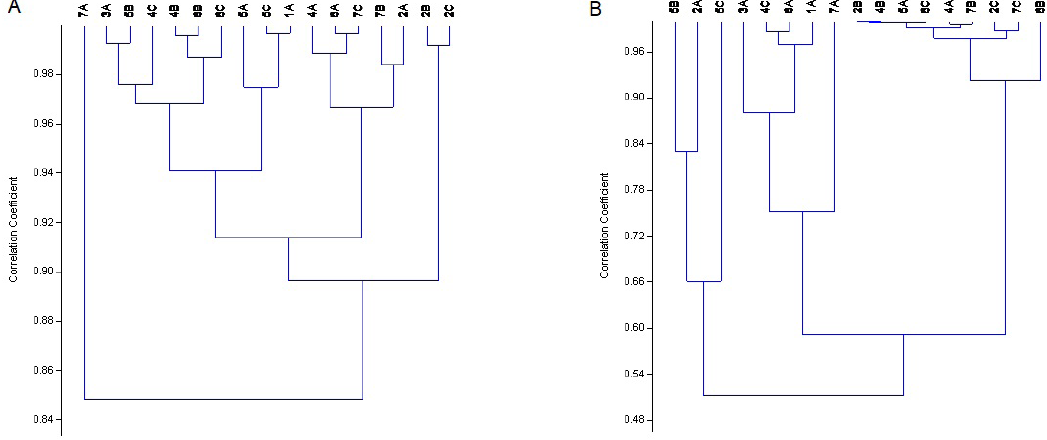
Figure 4. Cluster diagram showing the relationship among the sampling stations based on abundance of phytoplankton (a) and zooplankton (b) species.